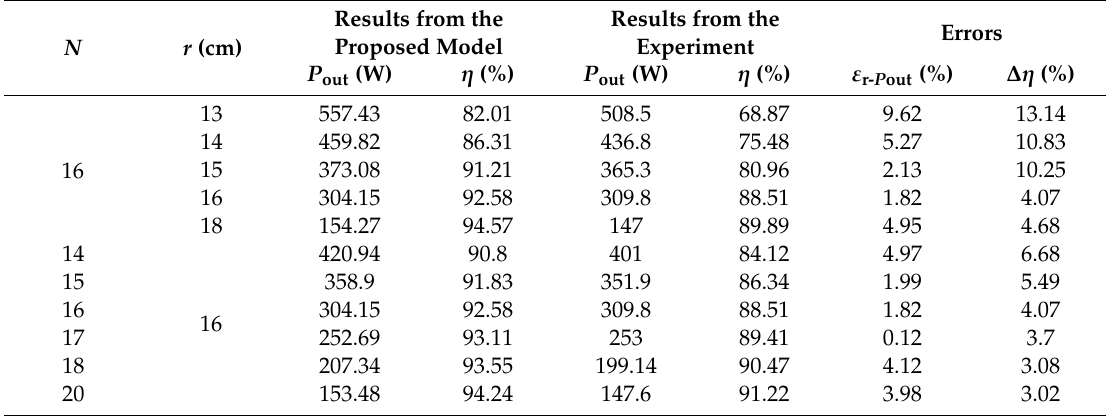
Table 4. Results from the proposed model and the experiment.